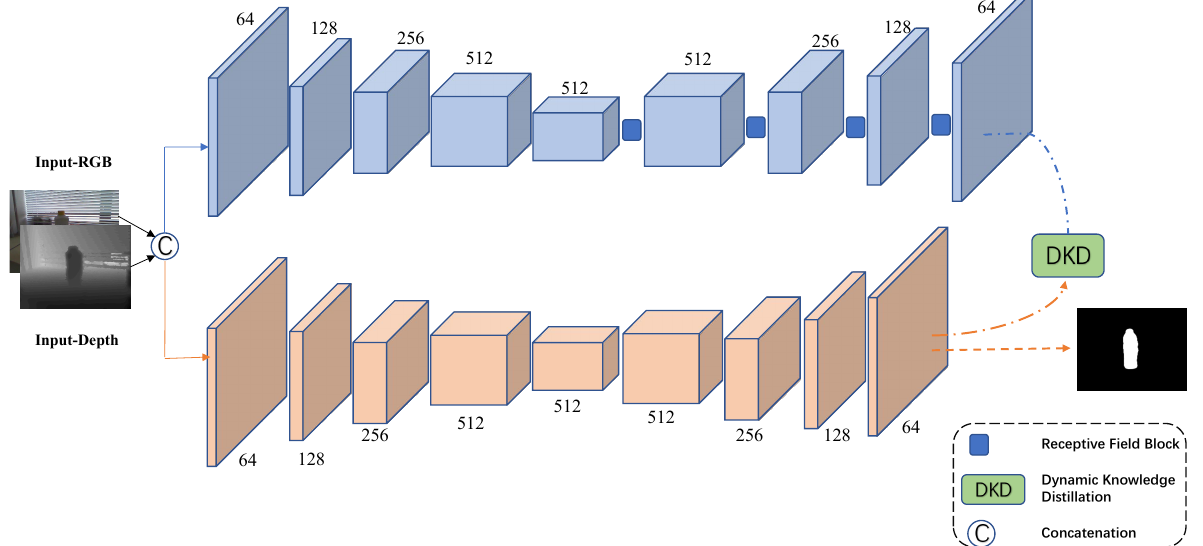
Figure 3. Our framework consists of two stages. We adopt a cumbersome network as the teacher model and a feature pyramid network as the student